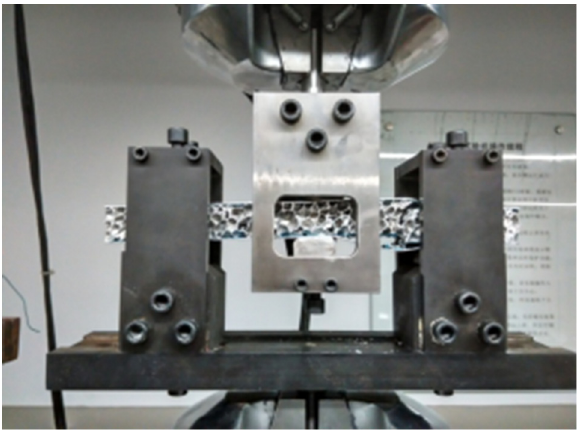
Figure 2. Loading diagram of the sample and fixture for fatigue tests.